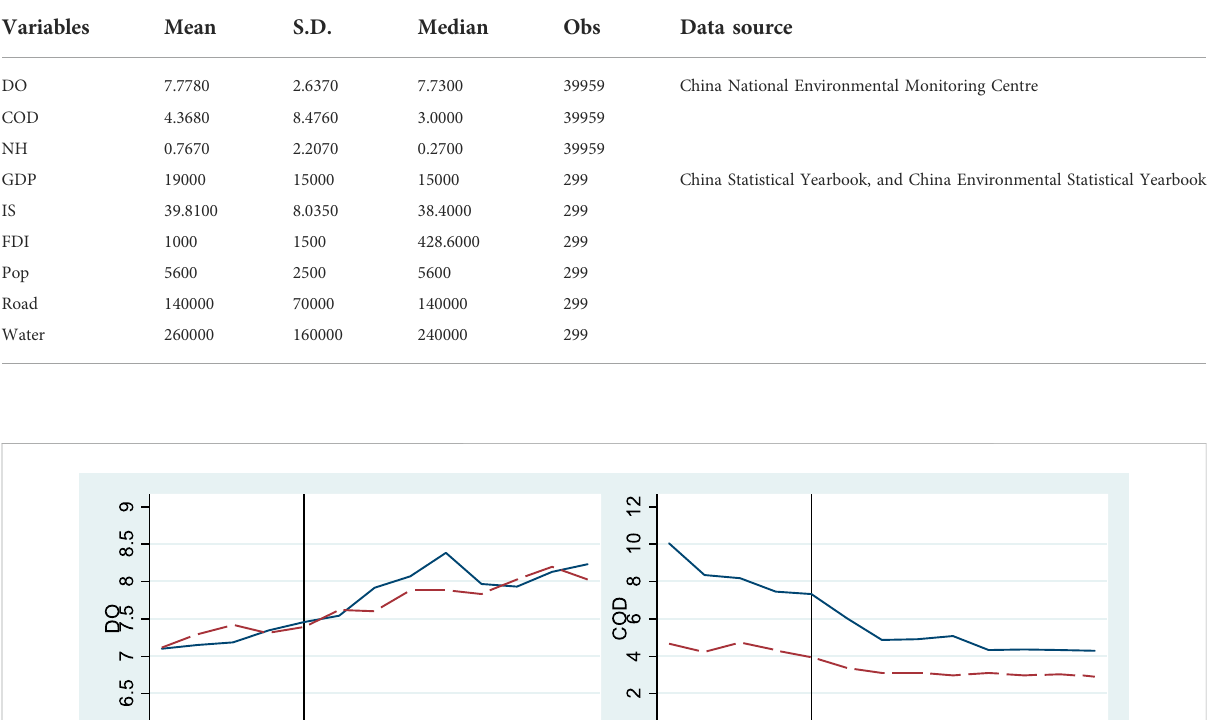
TABLE 1 Descriptive statistics for non-dummy variables.